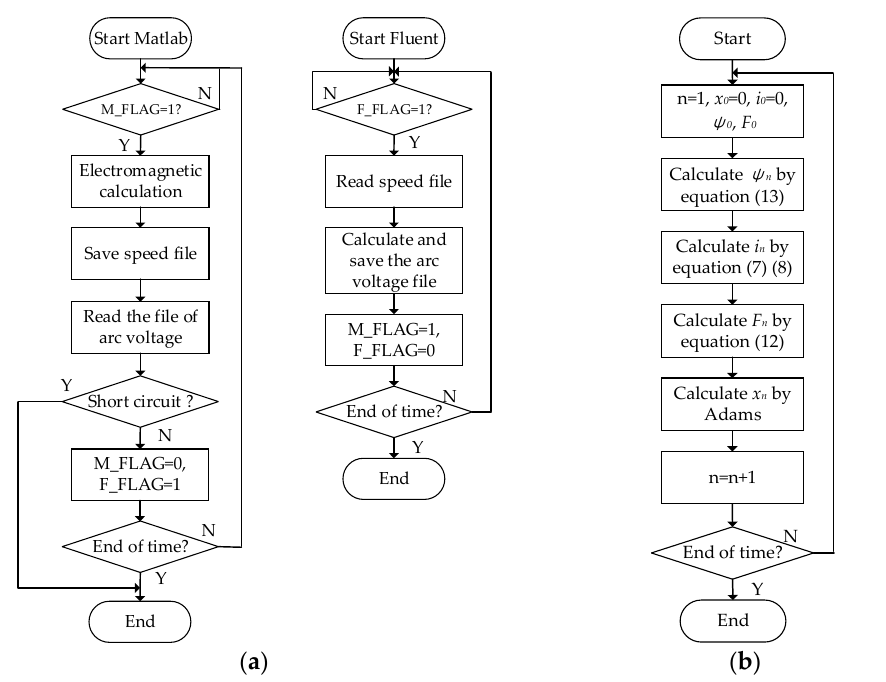
Figure 7. Flow chart. ( a ) Matlab and Fluent serial operation flow chart. ( b ) Electromagnetic calcula- tion flow chart.